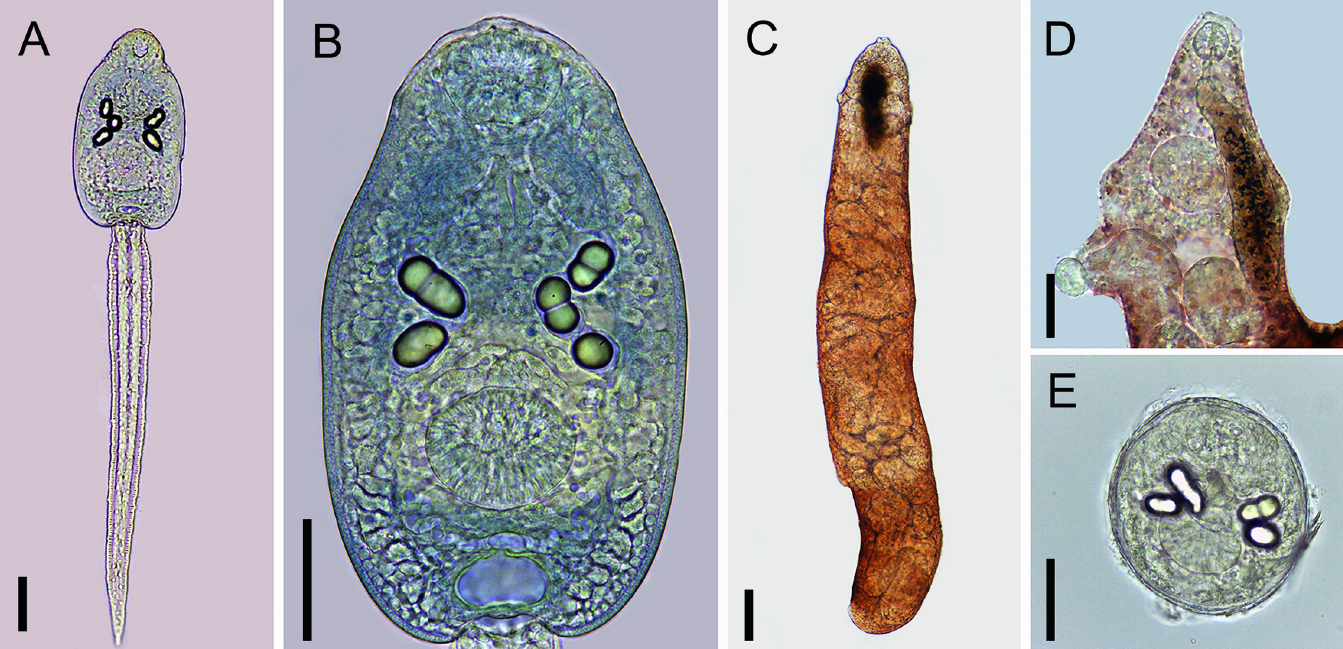
Fig 5. Larval stages of Rhopalias found in Biomphalaria straminea from Brazil. (A) Whole view of the cercaria stained with Nile blue sulphate. (B) Detail of the cercarial body stained with Nile blue sulphate. (C) Whole view of a redia. (D) Detail of the anterior region of a redia. (E) Metacercaria obtained experimentally in Poecilia reticulata . Cercariae from the same infected snail were molecularly identified as Rhopalias sp. 1. Scale bars: (A, B, D, E) 50 μ m, (C) 100 μ m.